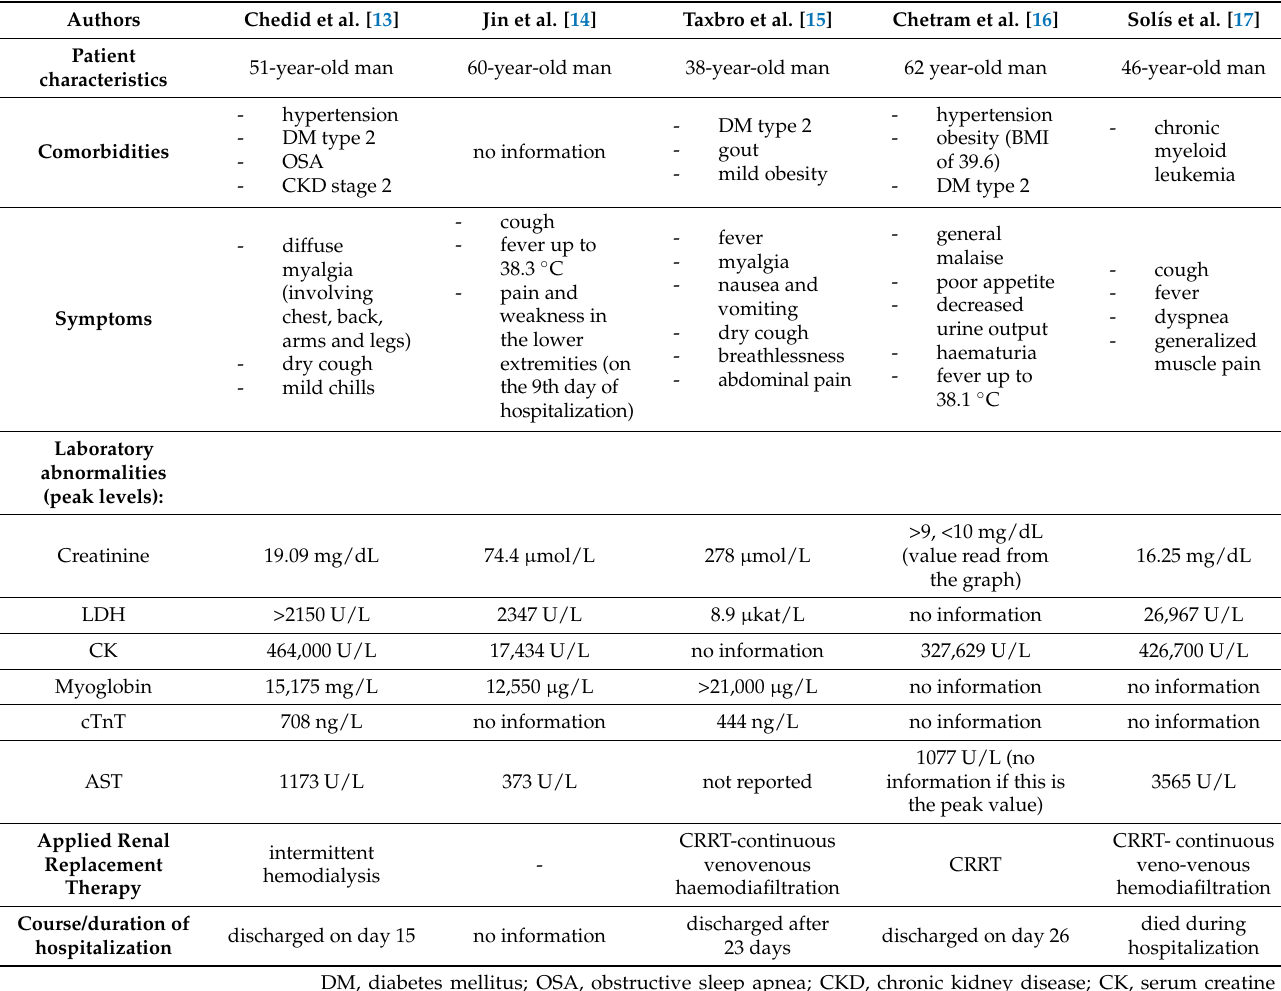
Table 5. Comparison of patients with SARS-CoV-2-induced rhabdomyolysis